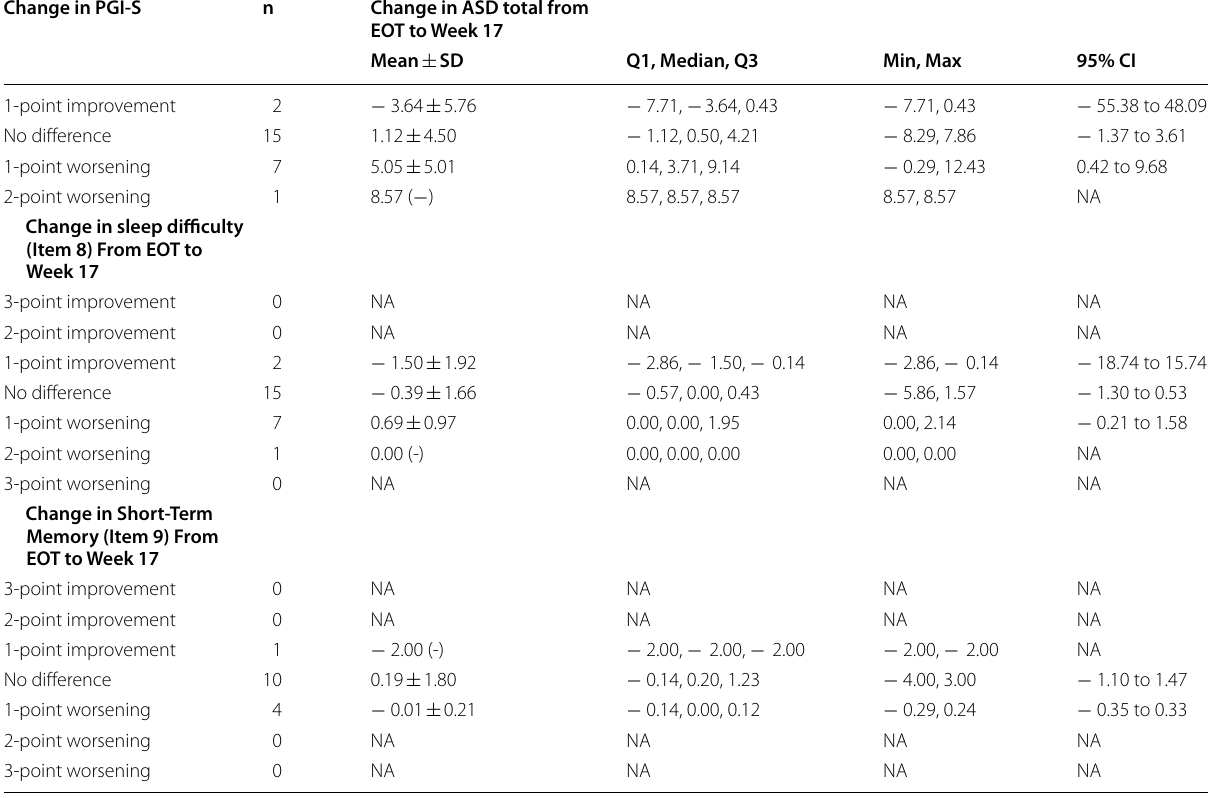
ASD Acromegaly Symptom Diary; CI = Impression of Severity; Q1